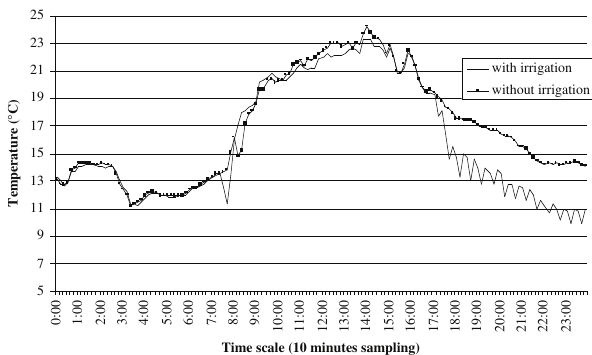
Figure 4. The effect of night time irrigation on the temperature of the pear plantation on the day when the air humidity was below 75% 2nd of May, 201